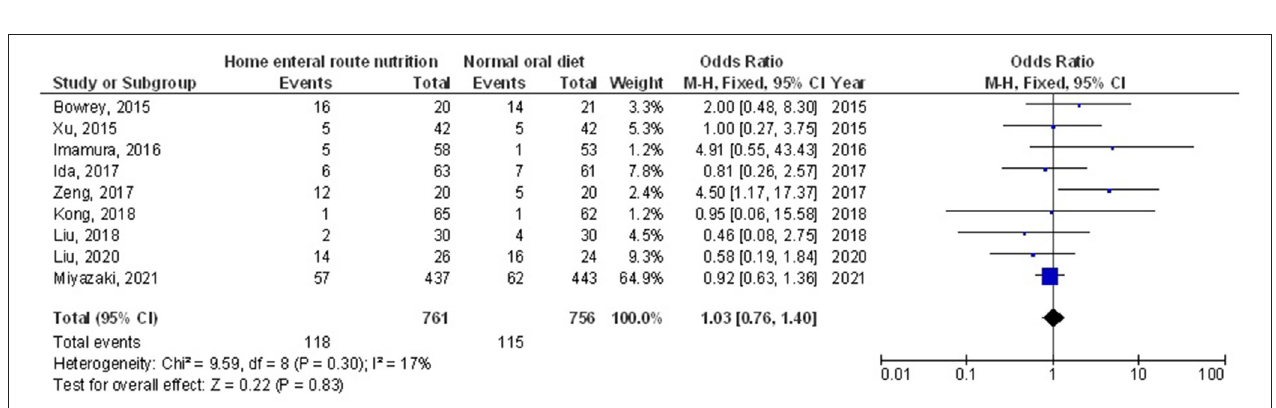
FIGURE 7 | A forest plot of the complications in subjects with upper gastrointestinal cancer resection with the home enteral nutritional support compared to the normal oral diet.